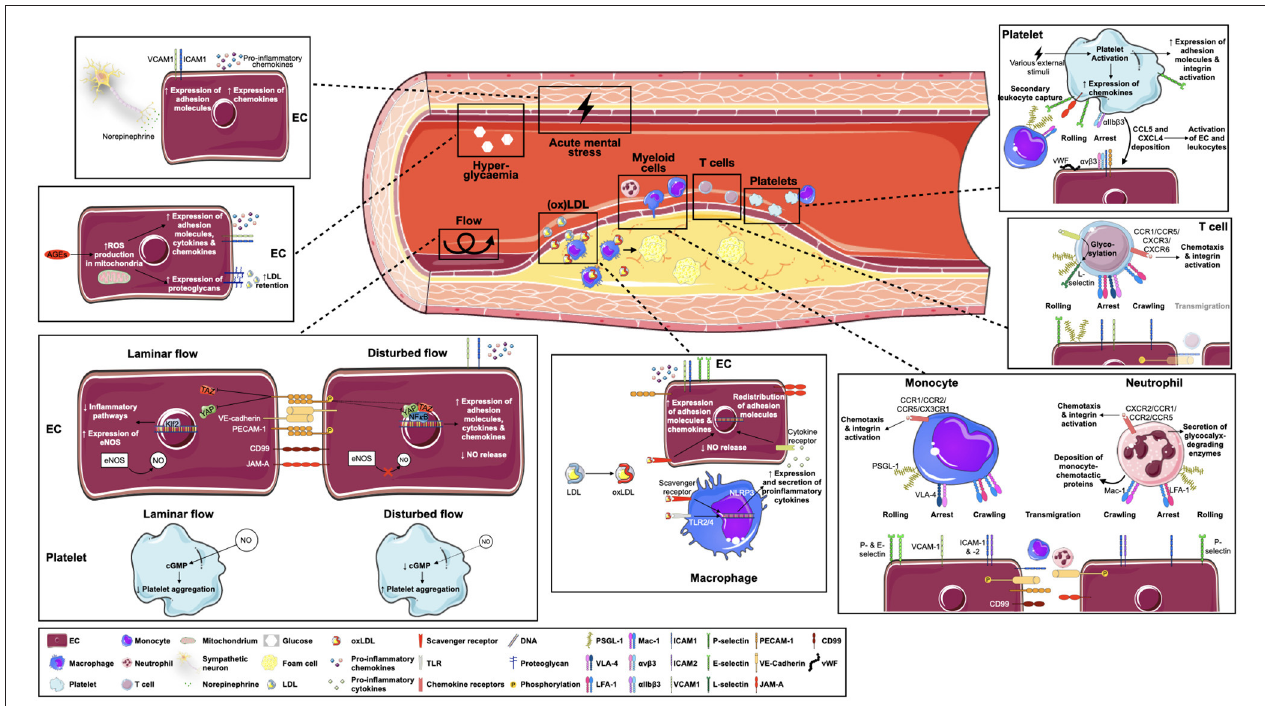
FIGURE 1 | Key factors in atherosclerosis-specific leukocyte recruitment. Leukocyte recruitment into atherosclerotic plaques is multifaceted and involves several players. Endothelial activation through disturbed flow patterns and oxidized lipoproteins, but possibly also via hyperglycemia or local sympathetic innervation, forms the basis for subsequent leukocyte-endothelial interactions. Of note, specific leukocyte populations respond differently to atherogenic triggers and use unique molecules and receptors to achieve leukocyte rolling, arrest, crawling and transmigration. Additionally, platelets strongly contribute to leukocyte recruitment by secondary leukocyte capture and activation of endothelial cells and leukocytes. AEG = advanced glycosylation end products; CCL, C-C motif chemokine ligand; CCR, C-C motif chemokine receptor; CD99, cluster of differentiation 99; cGMP, cyclic guanosine monophosphate; CXCL, C-X-C motif chemokine ligand;